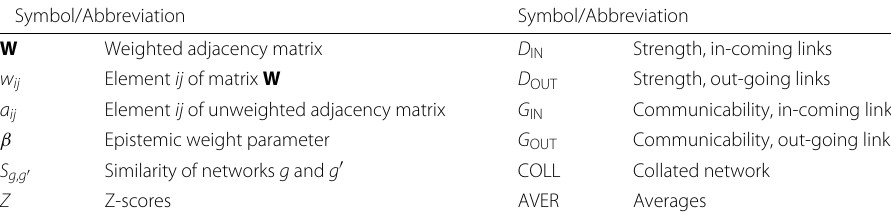
Table 2 Summary of symbols and abbreviations used in text and